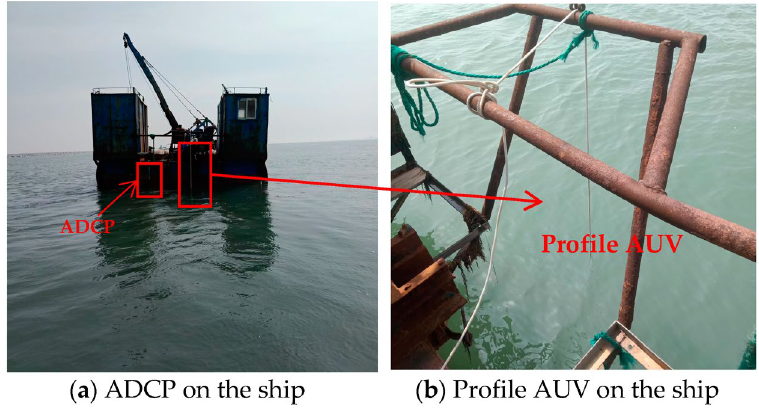
Figure 18. Offshore survey comparative experiment.